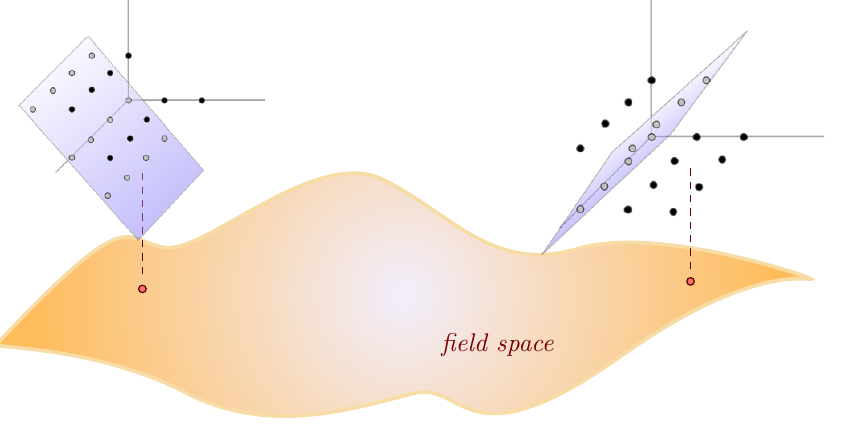
Figure 1 . EFT (cid:13)ux lattices at di(cid:11)erent regions in the (cid:12)eld space of a string theory